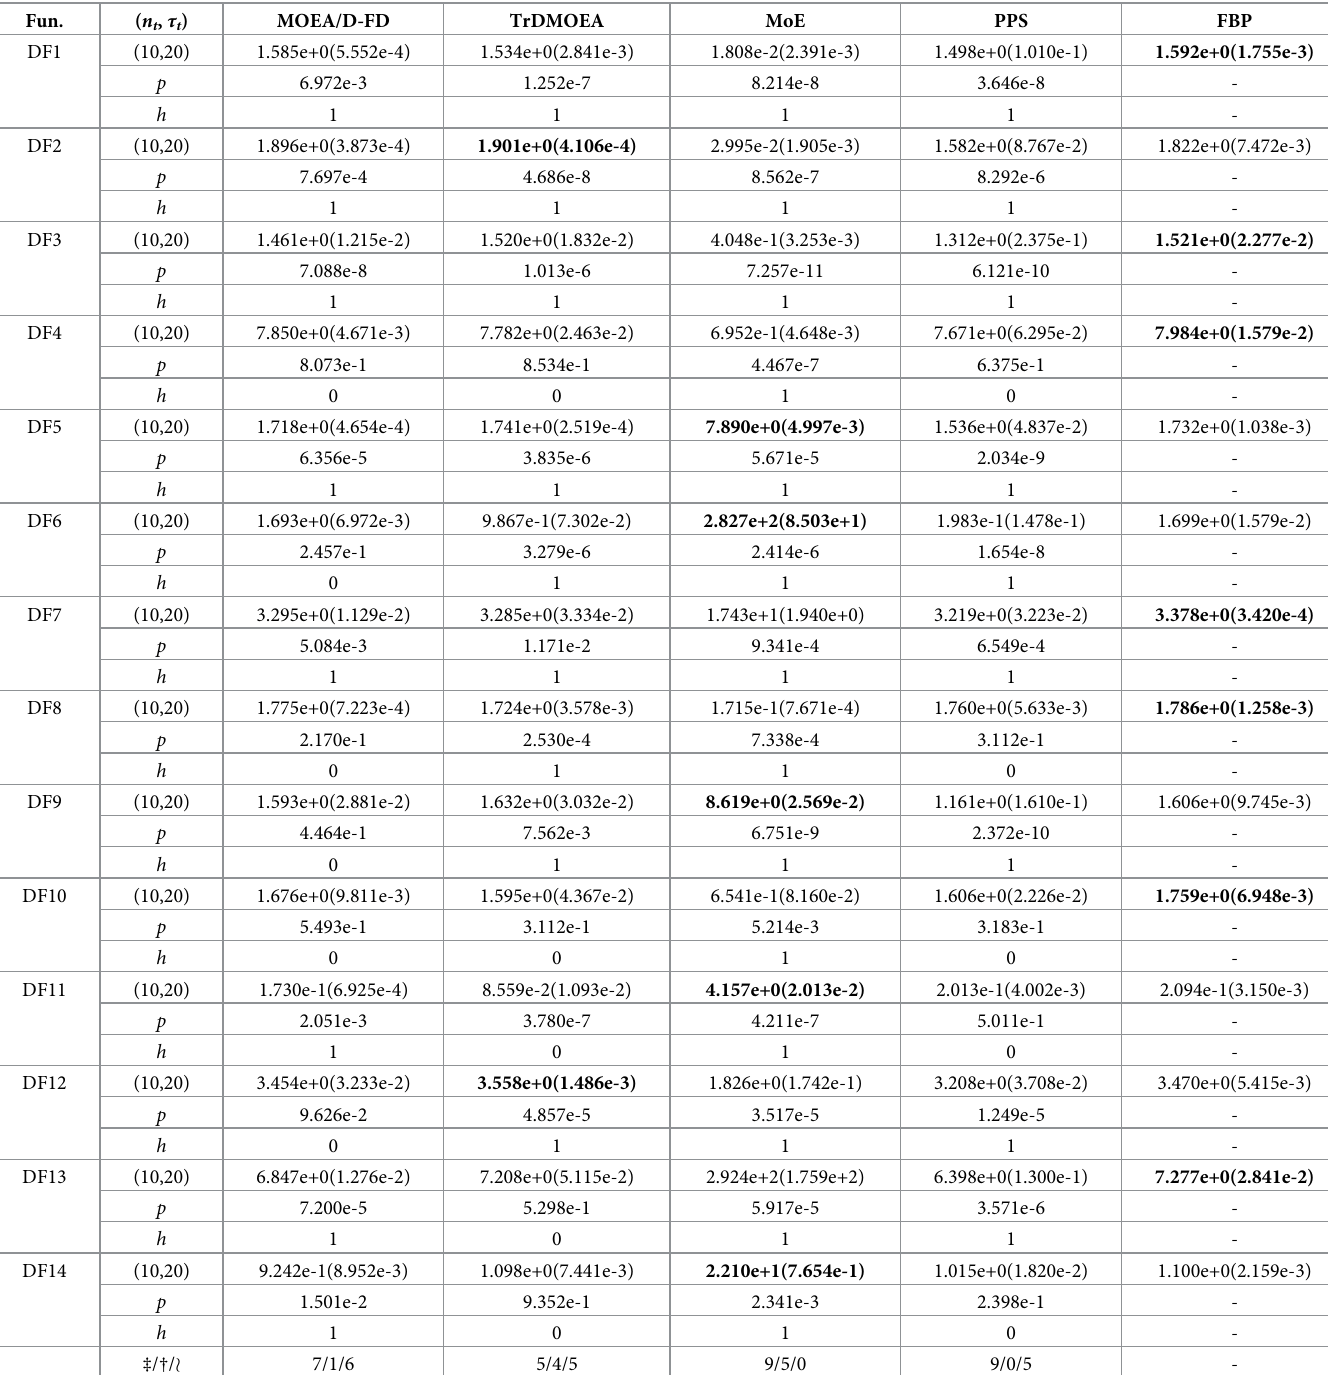
Table 6. Mean and standard deviation values of MHV obtained by five algorithms for ( n t , τ t ) = (10,20).